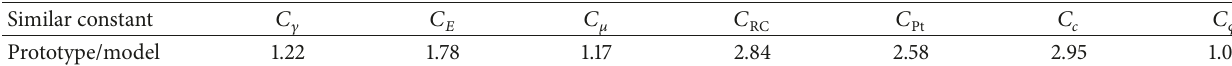
Table 2: Similarity constant of physical-mechanical parameters of prototype specimen and model.